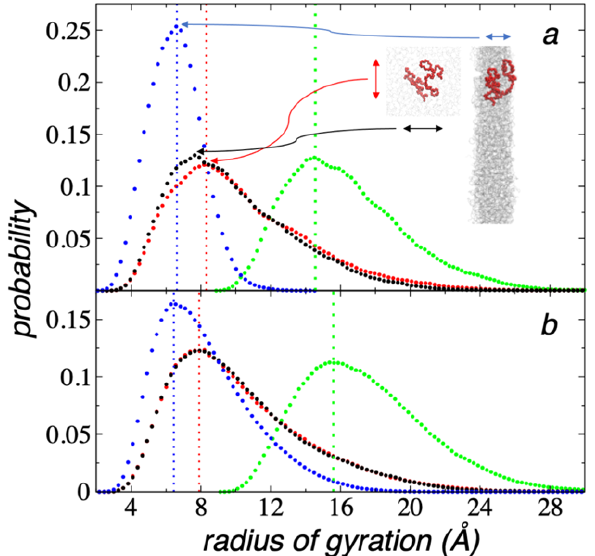
Figure 5. Histograms of the R g of thin liquid layers of melted polyethylene chains (C 200 ) at their t c in a liquid–vacuum equilibrium at ( a ) 373.15 K and ( b ) 673.15 K. Black and red points represent the components in the lateral directions to the interfacial surface, blue points represent components normal to the interfacial surface, and green points represent the total values of R g . Vertical lines represent the mode of the distributions. Snapshots in ( a ) represent normal and lateral views of a chain with R g values equal to the mode values of its correspondent distribution (highlighted with red spheres). The rest of the chains are represented with gray lines.